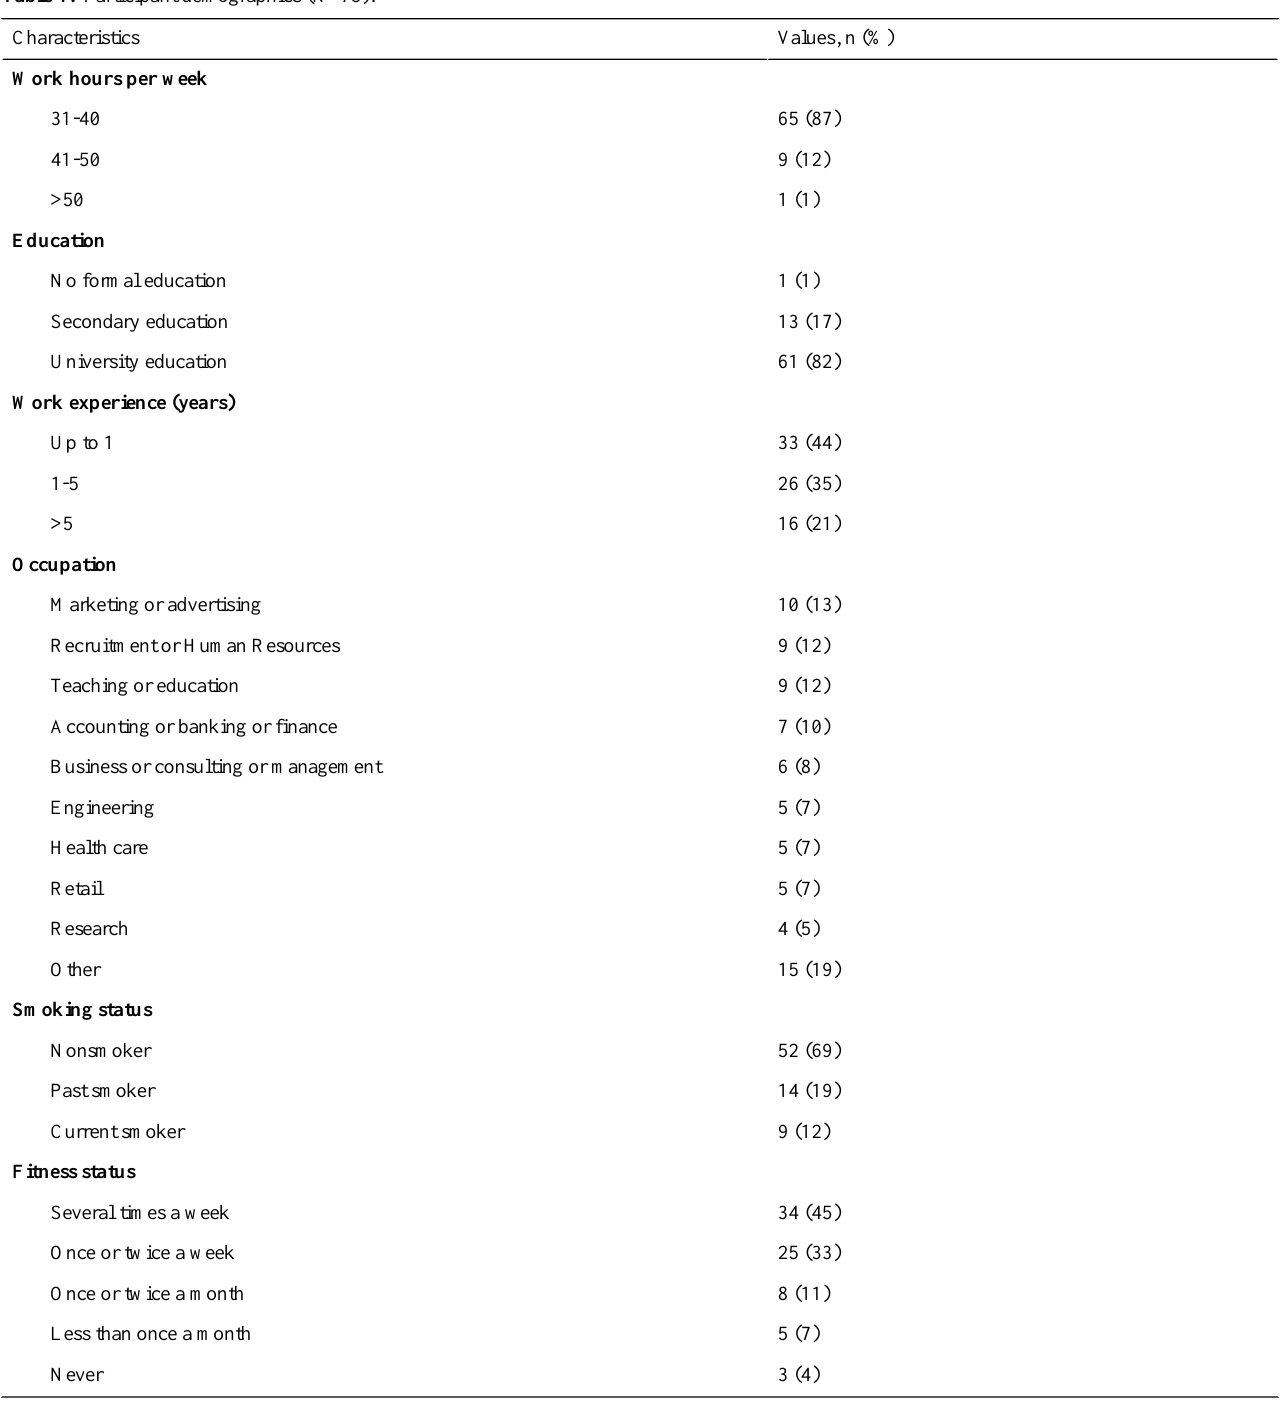
Table 1. Participant demographics (N=75).